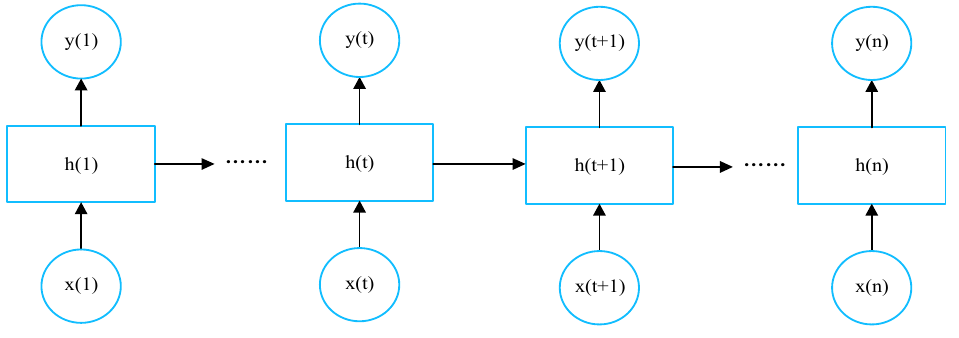
Figure 6. Recurrent neural network algorithm structure diagram.